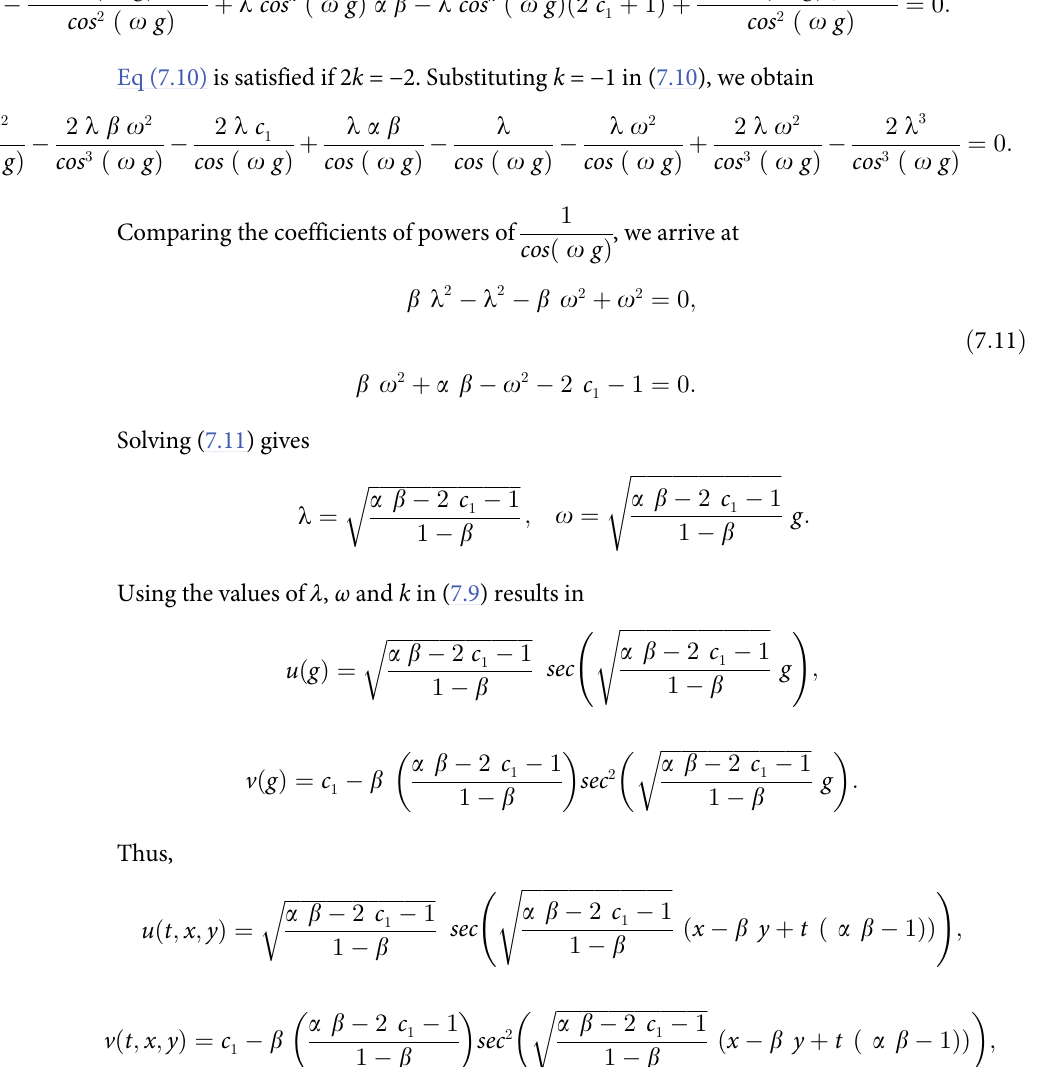
ffiffiffiffiffiffiffiffiffiffiffiffiffiffiffiffiffiffiffiffiffiffiffiffiffiffiffiffiffi a b (cid:0) 2 c (cid:0) 1 1